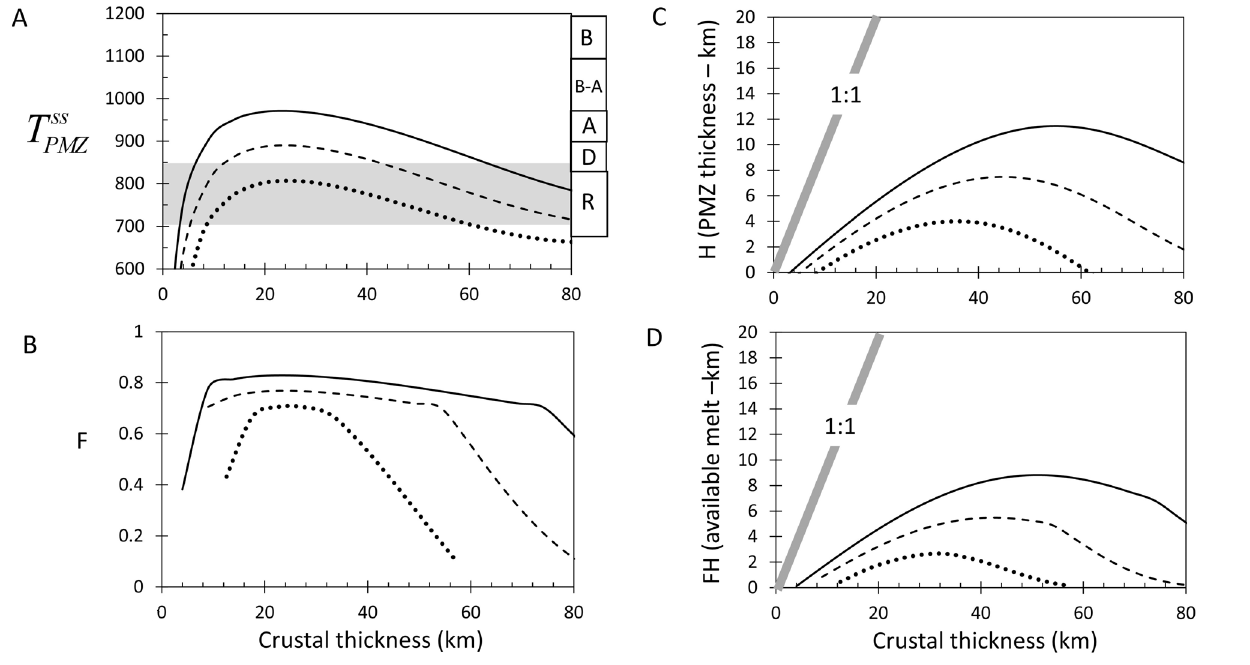
Figure 5: Characteristics of the lower crustal partially molten zone (PMZ) at steady state for a hydrous system. [A] Average steady state temperature of the PMZ ( T SS ) versus crustal thickness (km). Three curves are shown PMZ corresponding to different baseline levels of magmatic recharge rates J o ( km 2 Myr − 1 ) as shown in Figure 4. The in inset shows how J decays with crustal thickness; a characteristic decay length of 20 km was assumed for all in three cases. Solidus for a hydrous system is 700 °C. Gray zone represents temperature range of silicic plutons as inferred from Zr saturation temperatures [Miller et al. 1988; Lee 2014]. Right hand side bar represents approximate classification of magma type from Figure 4D. [B] Melt fraction ( F ) in the PMZ versus crustal thickness for different baseline levels of J o as shown in A. A hydrous system was assumed. [C] Thickness ( H ) of the PMZ versus crustal in thickness. Gray line represents 1:1 line where PMZ thickness equals crustal thickness. PMZ thickness never exceeds 20 % of the total crustal thickness. [D] Total available melt that can be extracted from the PMZ to the surface versus crustal thickness. This is determined by the product of F and H . All models are for a basal heat flow q of 15 mWm − 2 o